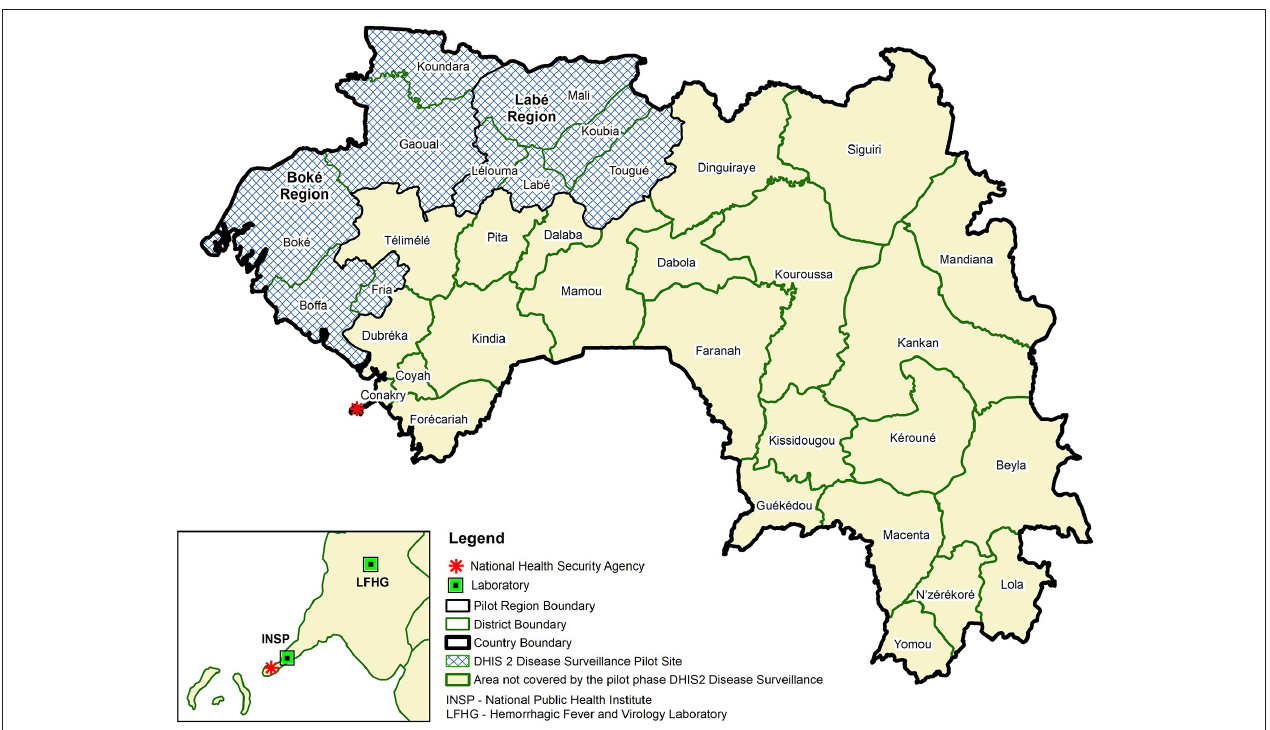
FIGURE 2 | Use of DHIS2 for disease surveillance pilot sites, Guinea,